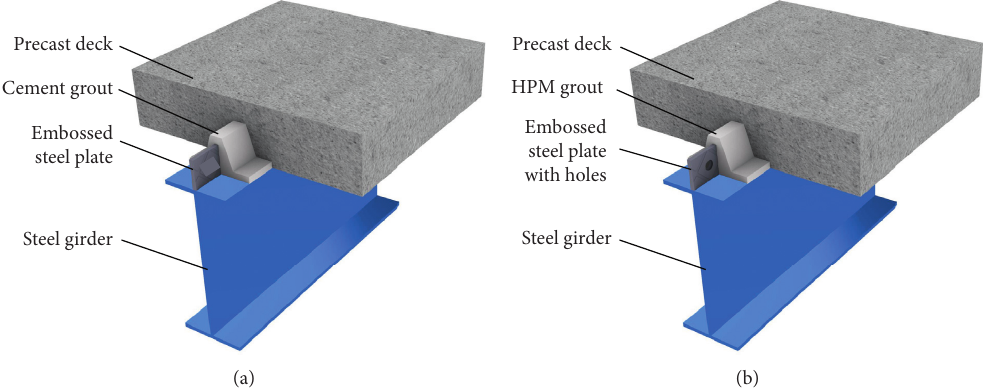
Figure 2: Details of adhesive connection: (a) first generation; (b) second generation.